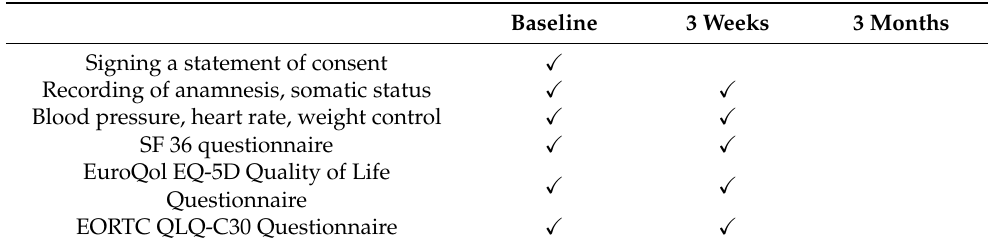
Table 3. The main criteria used in the current study for selecting the